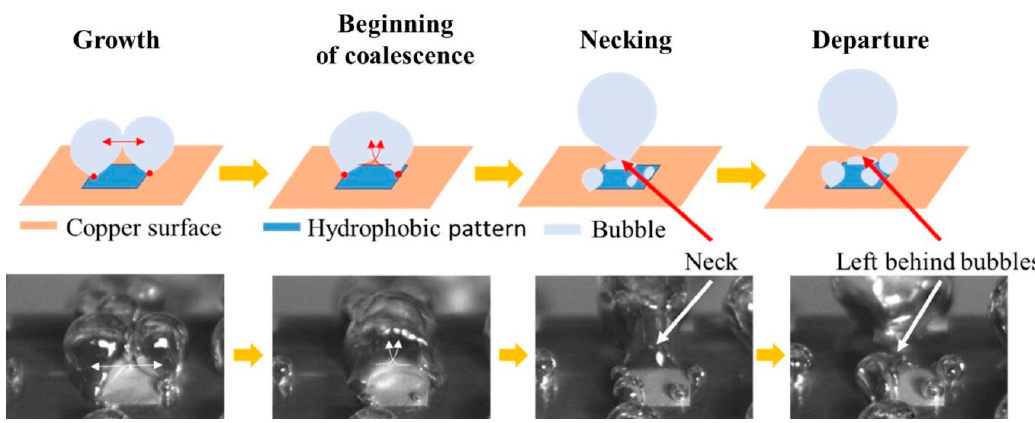
Figure 7. Bubble departure behavior of the pattern (ratio = 0.4) at the heat flux of 7 kW/m 2 .